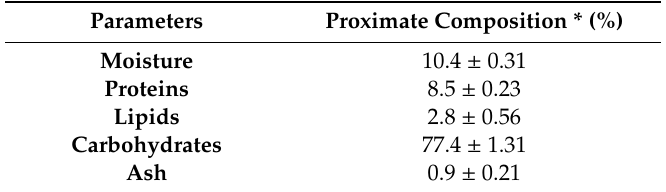
Table 1. Proximate composition of rice integral flour.